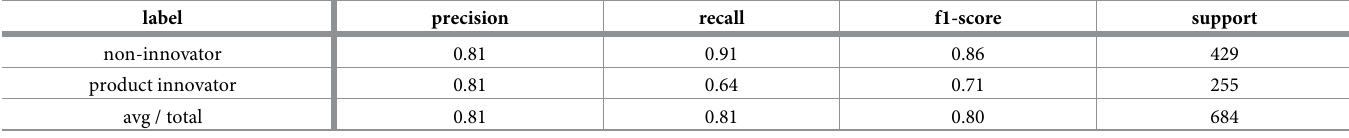
Table 2. Product innovator classification report for test set.